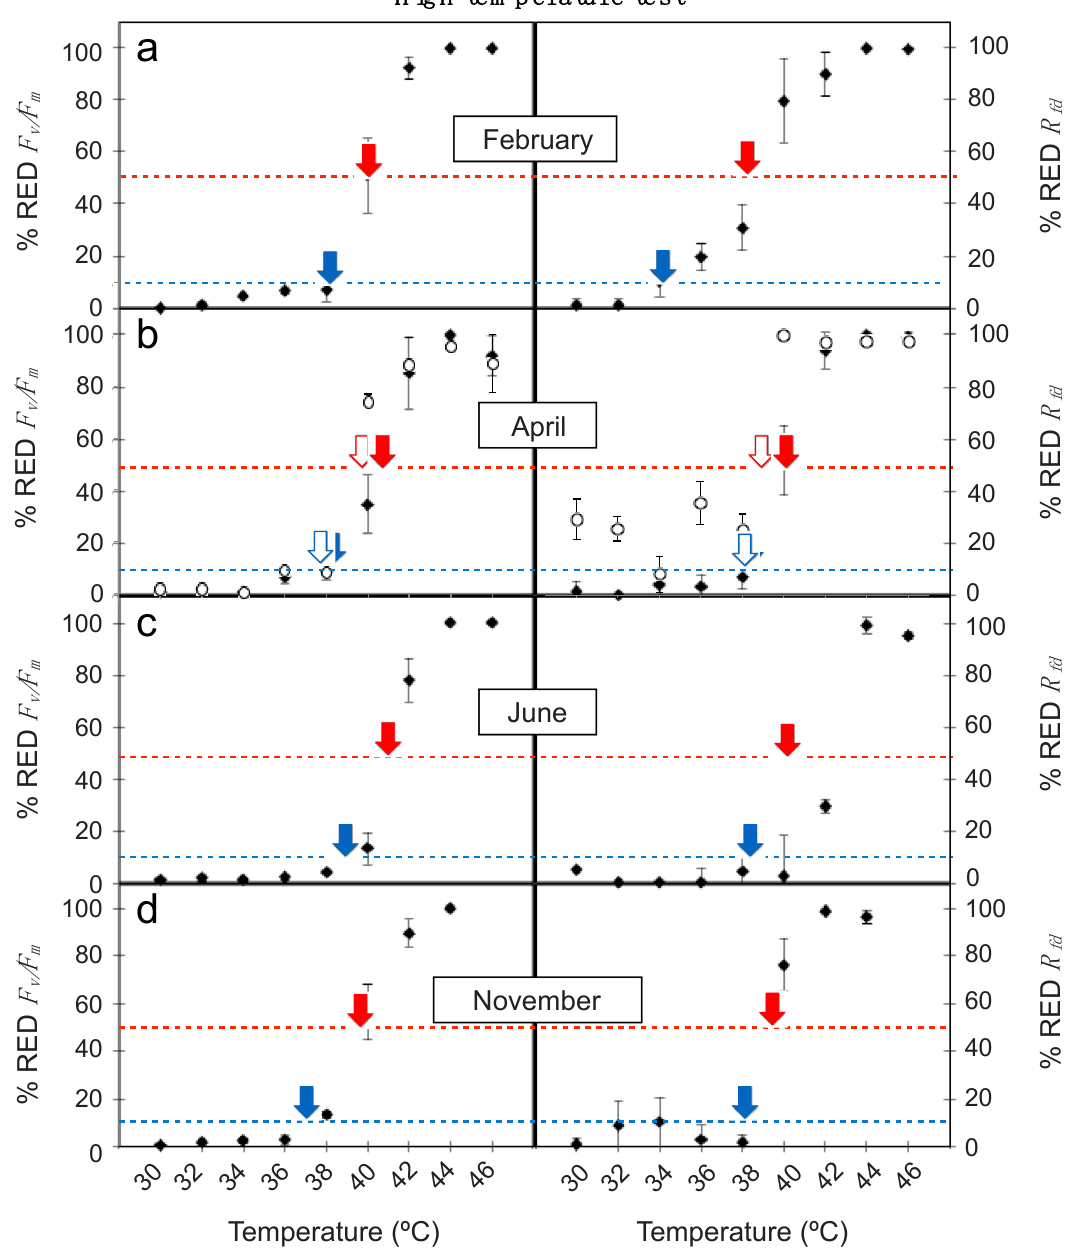
Figure 3. Effect of high temperature treatments in the reduction of F v /F m (% RED F v /F m ) and R fd (% RED R fd ) in mature leaves of E. scoparium along the year (close symbols) and in young leaves (open symbols) in April. Symbols are mean ± SD ( n = 6, except for young leaves where n = 3). Red and blue arrows indicate the LT 50 and the LT 10 , respectively, shown in Table 2. Table 2. LT 10 and LT 50 estimated from high temperature treatments from the maximal photochem- ical efficiency of PSII ( F v /F m ) and the R fd data shown in Figure 3 and obtained from the regression